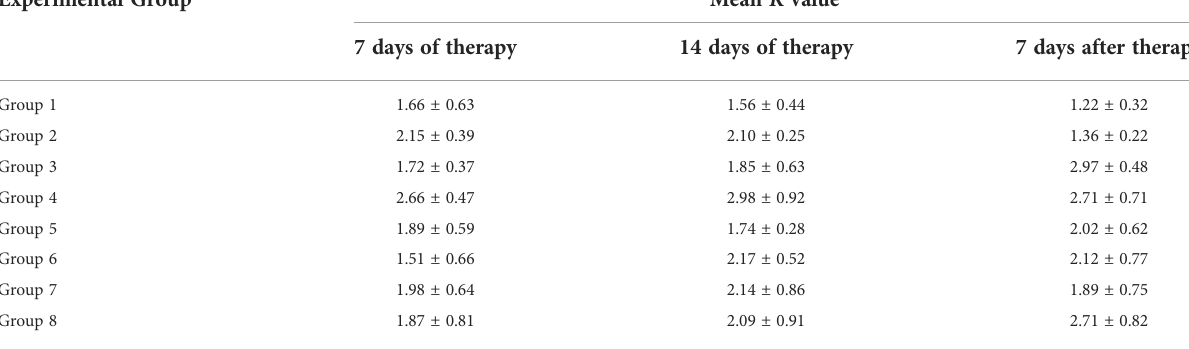
TABLE 2 Inactivation levels of phage vB_Sen-TO17 in chicken sera, as measured by determination of the K value. Mean of values with SD are shown. Experimental